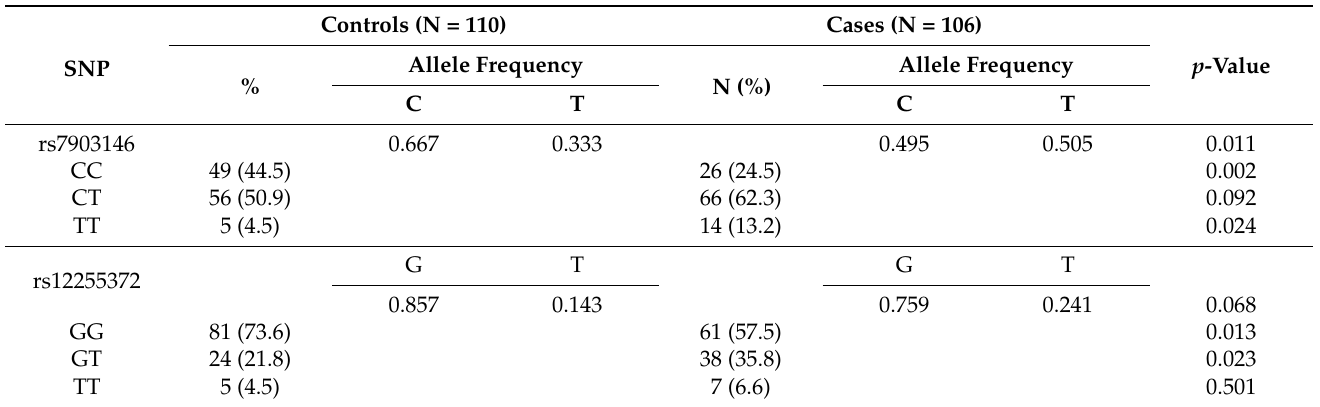
Table 2. Distribution of TCF7L2 gene polymorphism in cases and control participants.